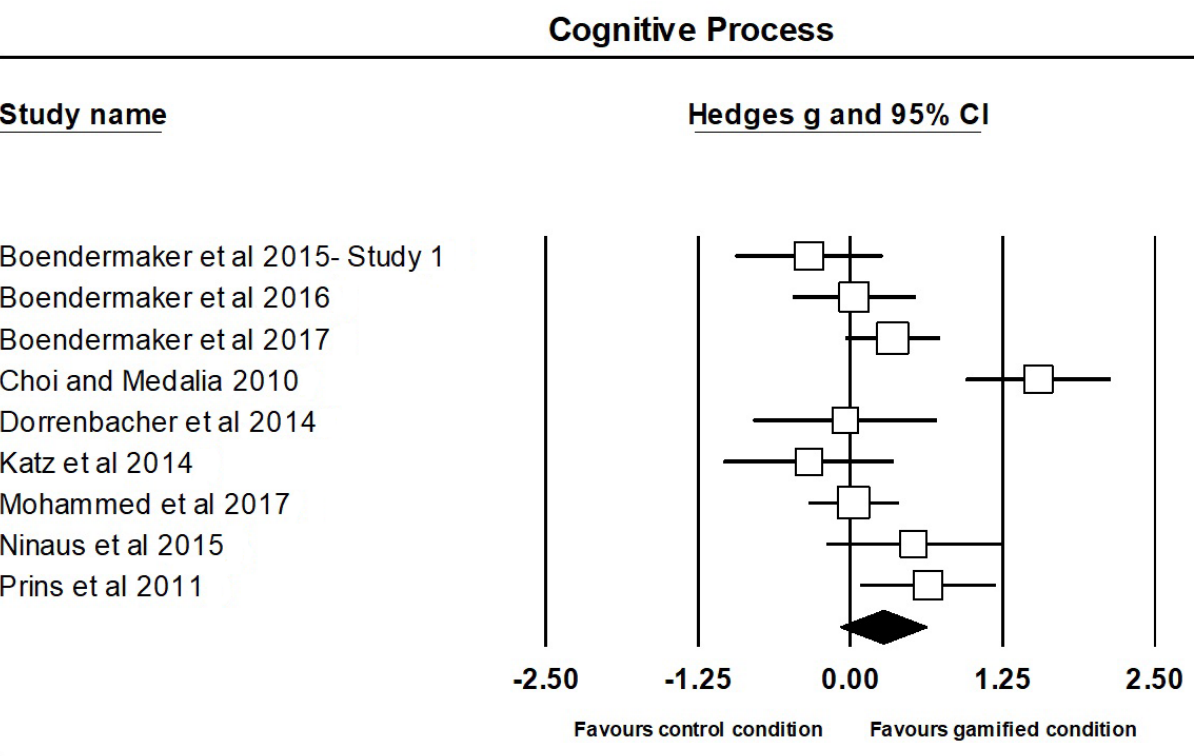
Figure 5. Forest plot of overall effect sizes comparing gamified condition and control condition (ie, non- or less-gamified version) on the cognitive process for individual studies in alphabetical